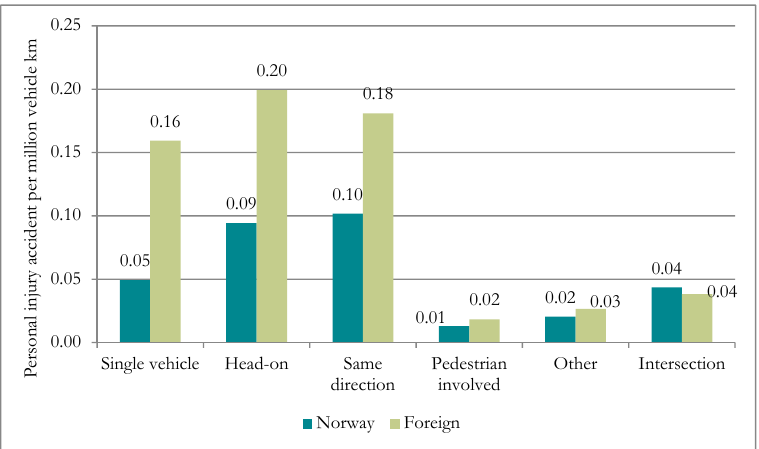
Figure 1. The risk of different accident types for Norwegian (N = 3320) and Foreign HGVs (396) involved in police reported traffic accidents with personal injury in Norway 2007–2012. Figure 1 indicates that foreign HGVs have a three times higher accident risk of single vehicle accidents than Norwegian HGVs, twice the risk of head-on collisions, and nearly twice the risk of collisions with vehicles driving in the same direction. The risk of being involved in intersection